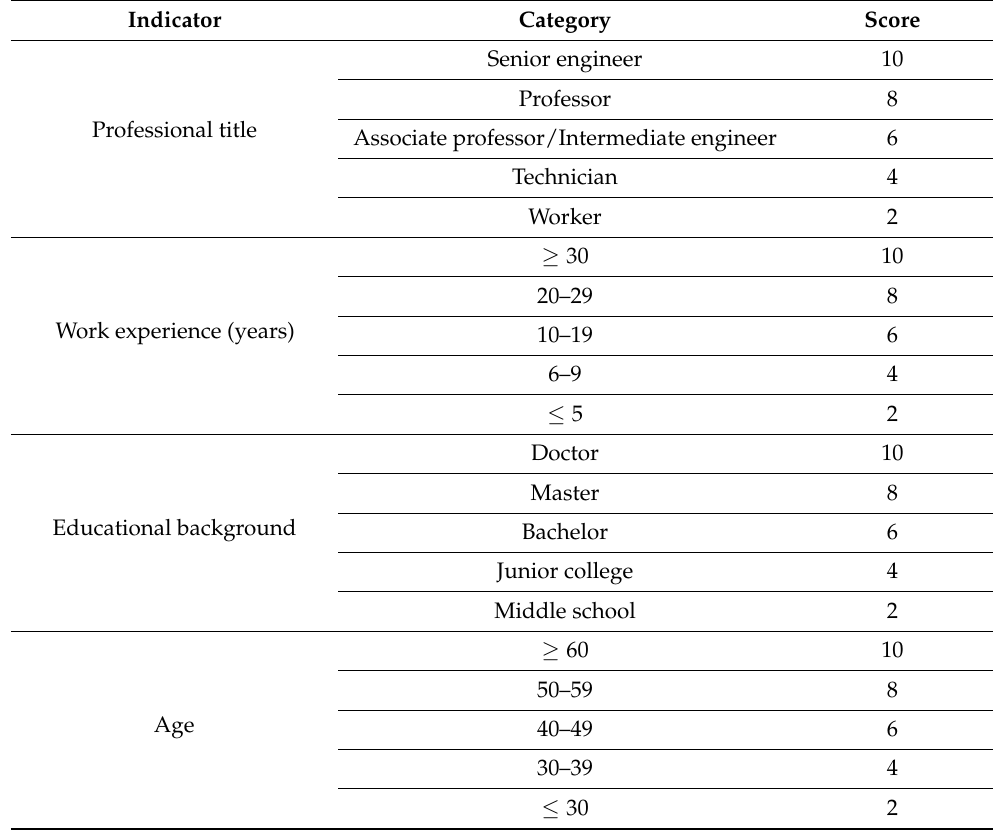
Table 2. Experts’ weight and corresponding